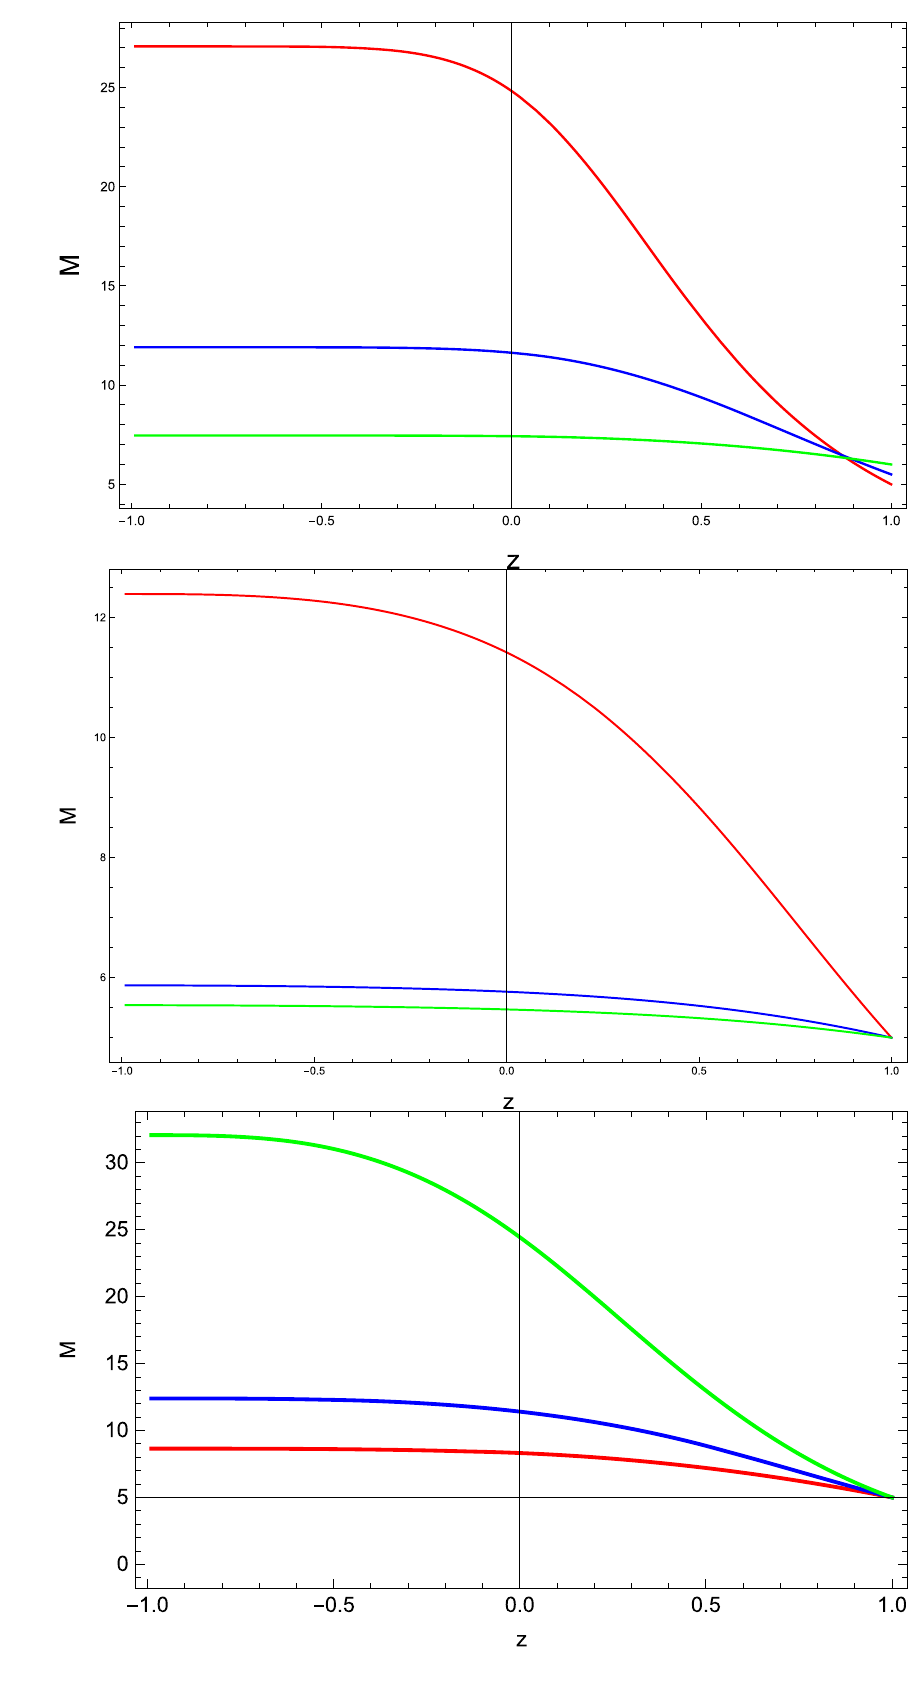
Fig. 7 Evolution of PBH mass M ( z ) with redshift z for different λ in case of an Emergent Universe. Here λ = 0 . 0005 (red), λ = 0 . 001 (blue) and λ = 0 . 002 (green)